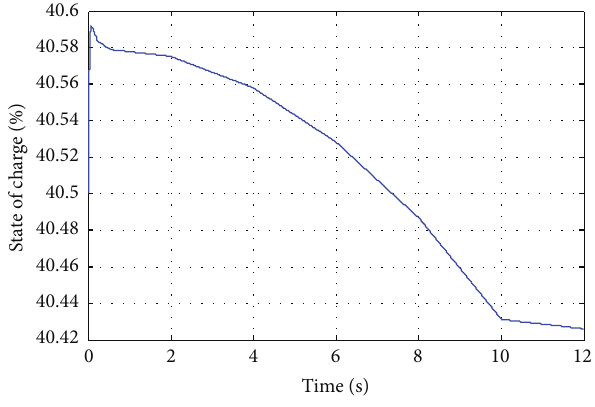
Figure 6: Evolution of the SOC in the different phases.